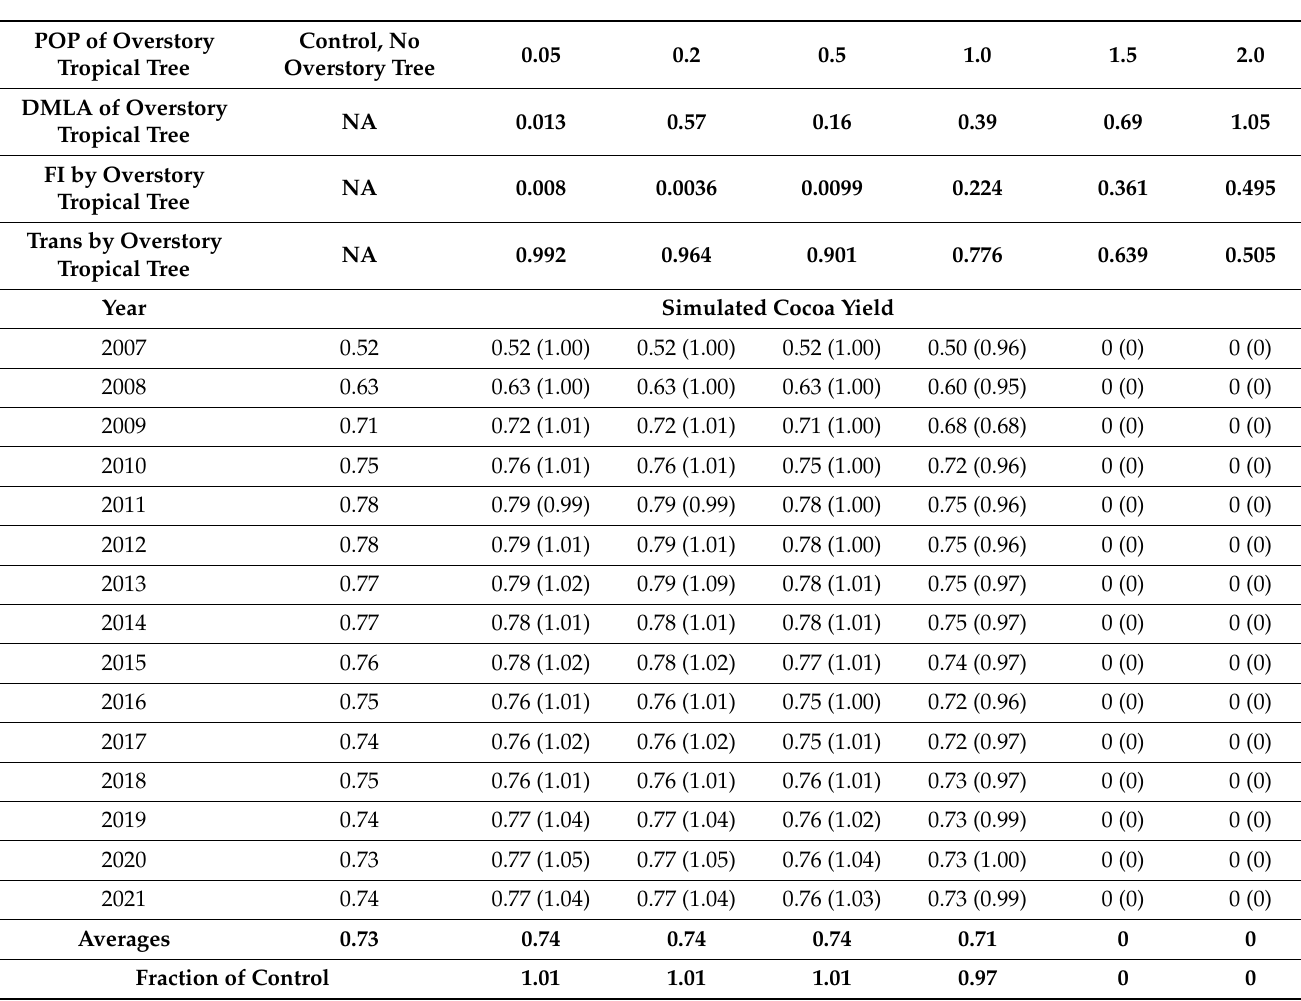
Table 11. Cocoa simulation with tropical tree overstory growth planted five years prior to cocoa. POP is the plants per 100 m 2 of the tropical trees. DMLA is the potential LAI of the overstory trees. The fraction of light intercepted by the overstory tree (FI) and the fraction transmitted beneath the overstory (Trans) are calculated from the potential LAI (DMLA) and Beer’s Law with the appropriate extinction coefficient. Simulated cocoa yield in Mg/ha is indicated and the yield divided by the control is in parentheses.